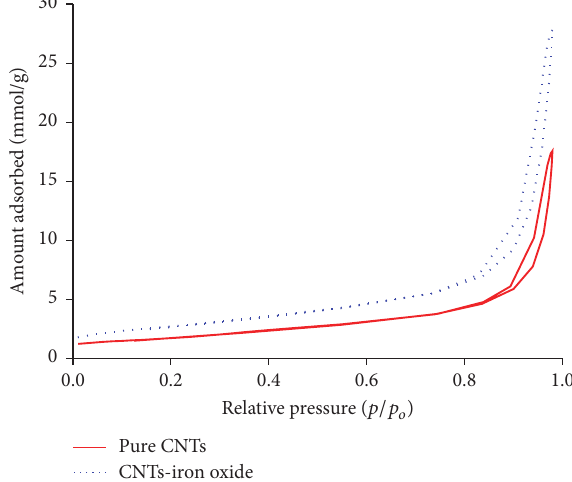
Figure 6: Nitrogen adsorption desorption isotherms for pure and iron oxide impregnated